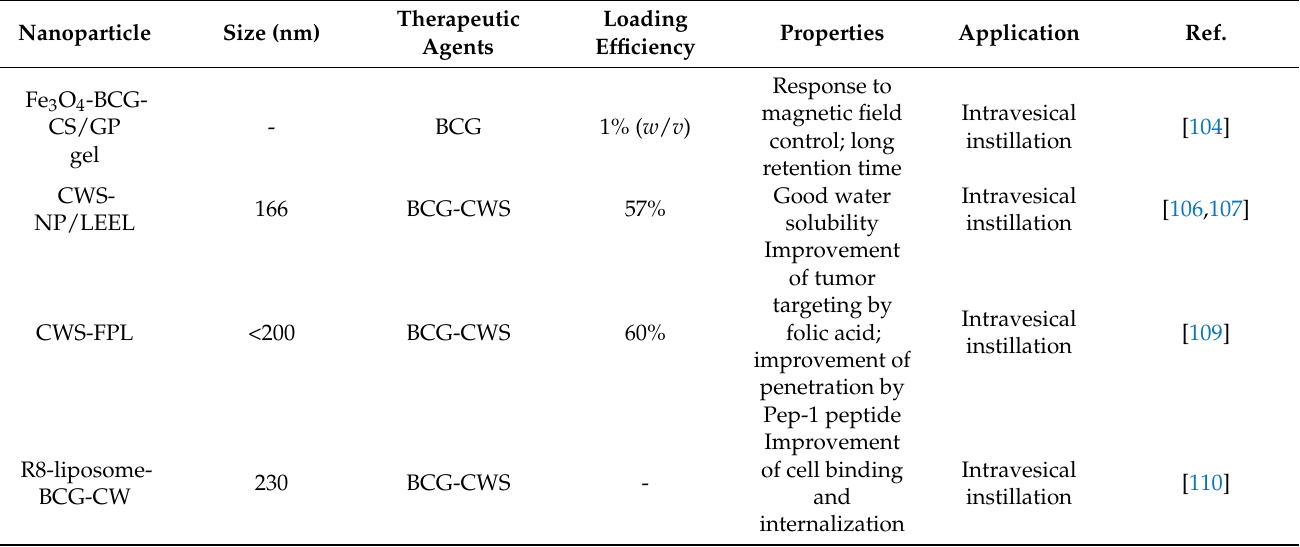
Table 5. Nano-formulations for immune